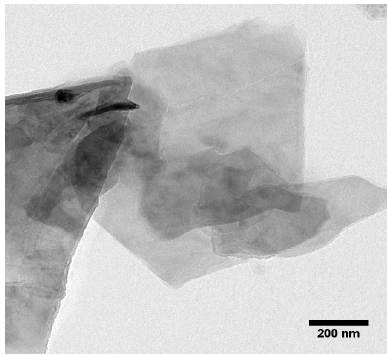
Figure A2. Ultraviolet-visible spectrophotometry (UV-vis) of GONPs, with maximum absorbance at 227 nm. Nanomaterials 2018 , 8 , x FOR PEER REVIEW 14 of 16